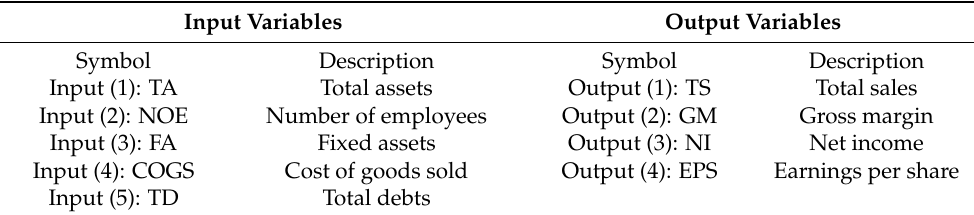
Table 1. The input and output